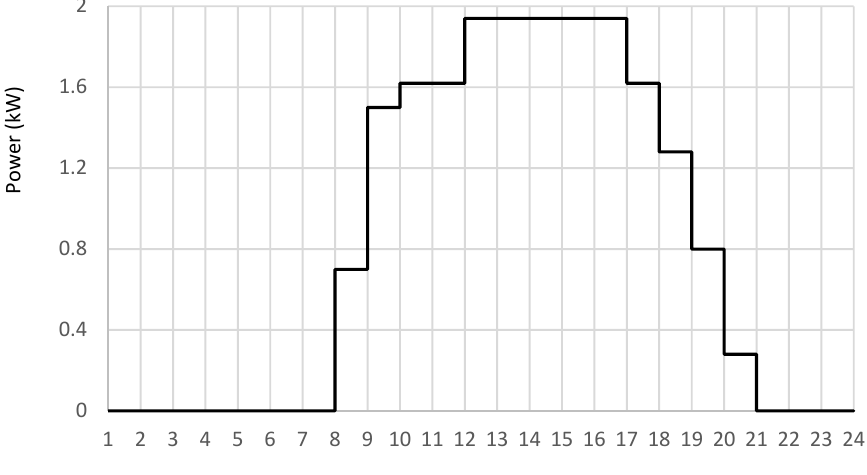
Figure 3. The hourly changing electricity prices, with the slots.